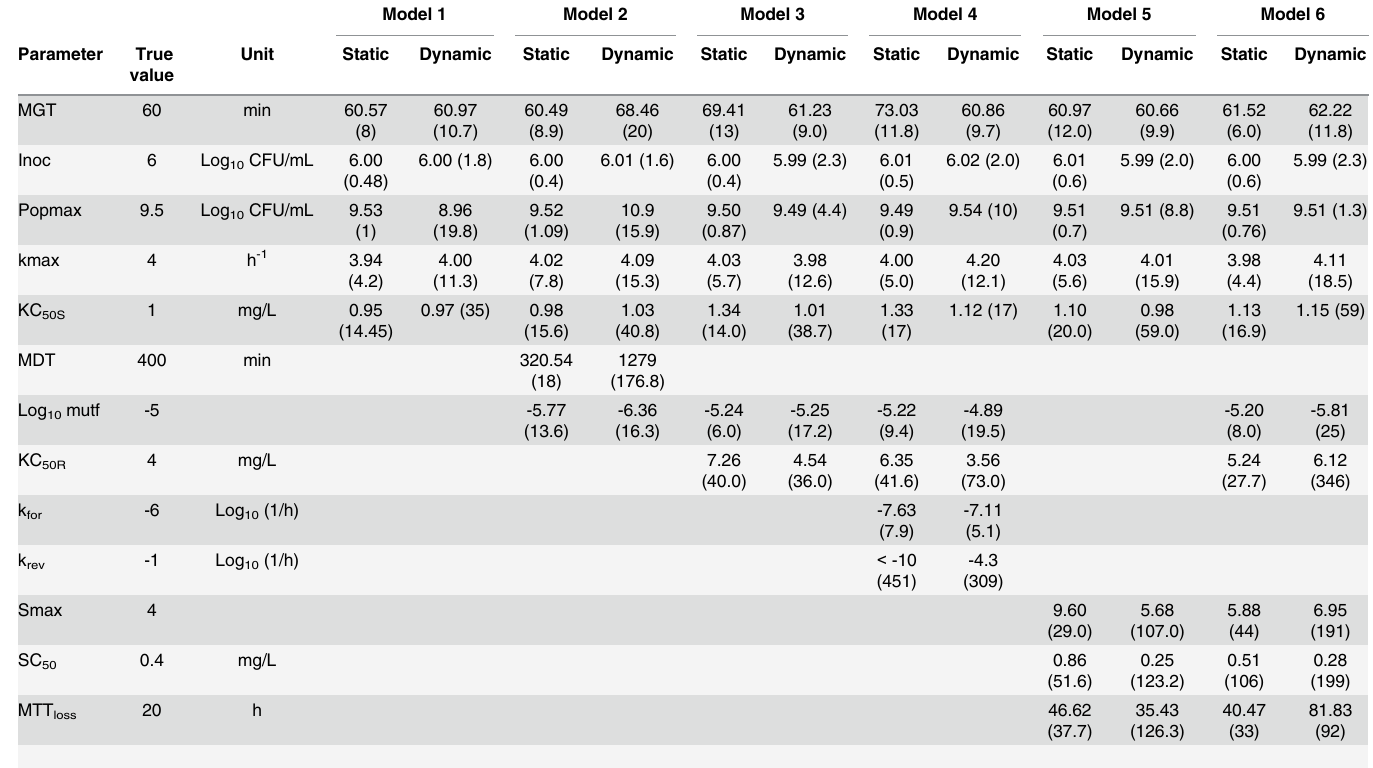
Table 4. Median and coefficient of variation (CV) of parameter estimates (n = 1200; i.e. 100 replicates for each setting and each model) under static or dynamic